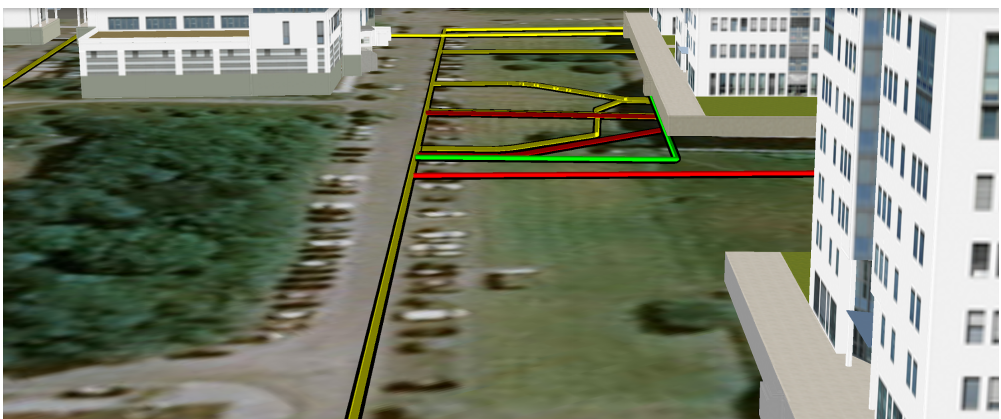
Figure 9. Pipes and their ditches in a 3D scenario simulating a street.